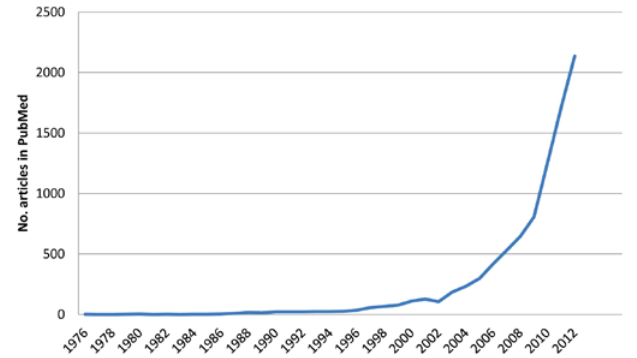
Figure 1. Number of articles indexed in PubMed which contained “global health” as a term anywhere in the text or bibliographical information.